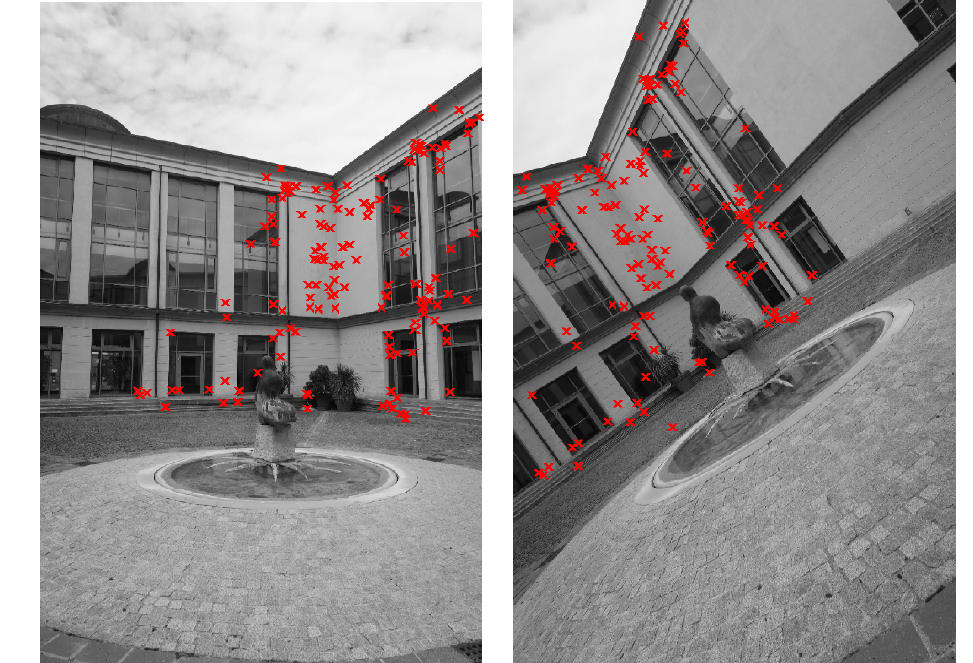
Figure 12. Example of feature points matched by taking into consideration geometry constraints (second case